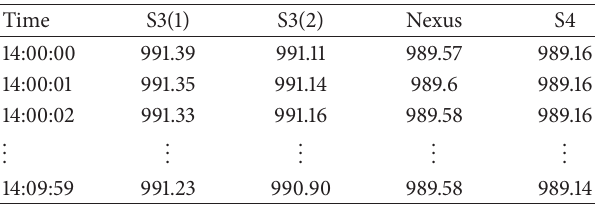
Table 5: F -test result for a sample observation. Table 6: Sample raw data from a 10-minute